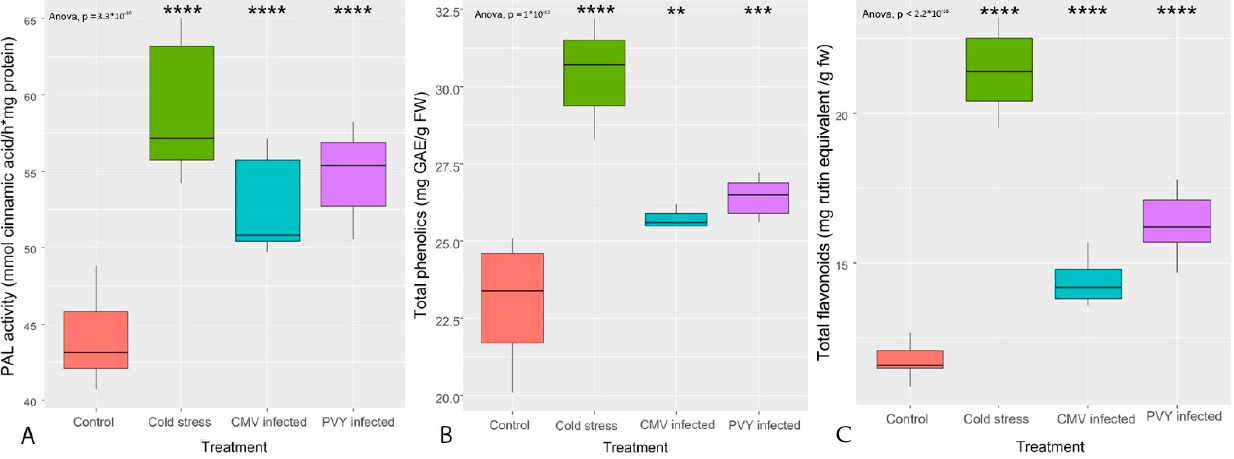
Figure 2. Phenylalanine ammonia-lyase (PAL) enzyme activity ( A ), total phenolic level ( B ), and total flavonoid content ( C ) of tomato leaves (cv. Elpida) following plant exposure to cold stress (5 °C for 16 h) or inoculation (20 d) with either cucumber mosaic virus (CMV) or potato virus Y (PVY). Control and cold-stressed plants were mock-inoculated. Significant differences were determined by one-way ANOVA comparisons ( p ≤ 5%). Signif. codes: ns: non-significant; 0.05: *; 0.01: **; 0.001: ***; 0: ****.